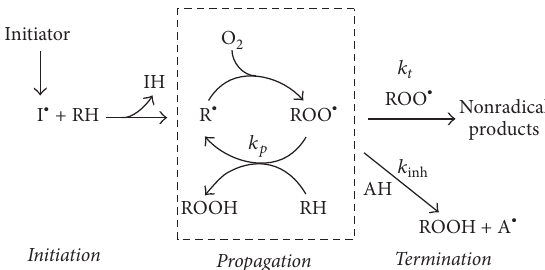
Scheme 1: Chain reaction of autoxidation for a substrate (RH) and mode of interference by chain-breaking antioxidants (AH).